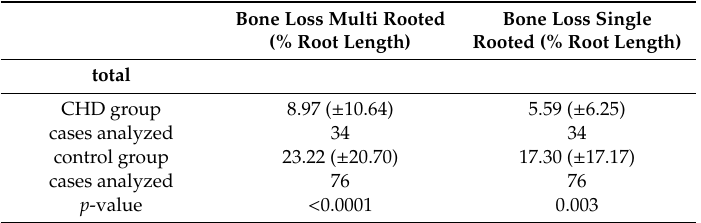
Table 7. Periodontitis among patients with CHD and healthy control subjects. Analysis of di ff erences between groups has been done with Mann–Whitney test, analysis between subgroups (CHD complexity) with Kruskal–Wallis test. Bone loss: loss of supporting bone in % of root